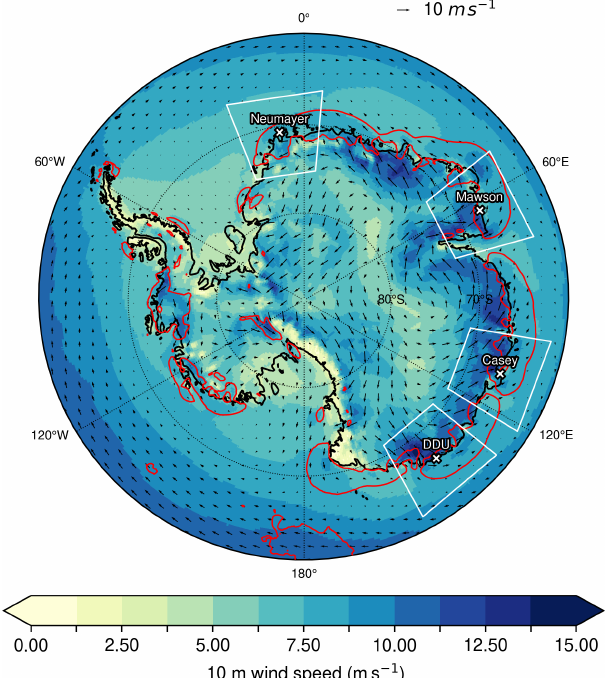
Figure 1. Mean ERA5 10m wind speed for the period January 2010 to December 2017 (shaded). The 4ms − 1 contour of the standard deviation of 12-hourly 10m wind speed for the same period is over- lain in red. White boxes indicate the regions selected for the SOM analysis, with labelled station locations. The arrows represent vec- tor average wind speed, and thus go to zero length in regions with zero directional